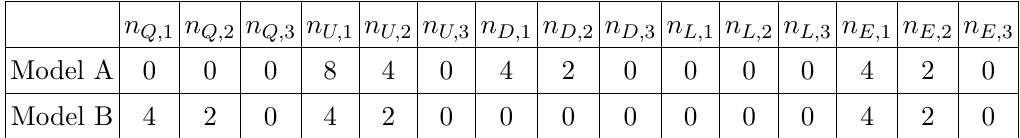
Table 3 . Number of heavy (cid:12)elds in the two models discussed in section 3.2. The numbers of SU(2)-singlet and -doublet heavy (cid:12)elds verify relations such as (3.5). which (cid:12)t well the phenomenological values for quarks and mixings when tan (cid:12) is large. When the FN super(cid:12)elds do not feature any doublet (i.e. n number of heavy (cid:12)elds derived from table 2 and reminded in table 3), choosing h and x = (cid:0) 3(3 X Q + X L ) 2